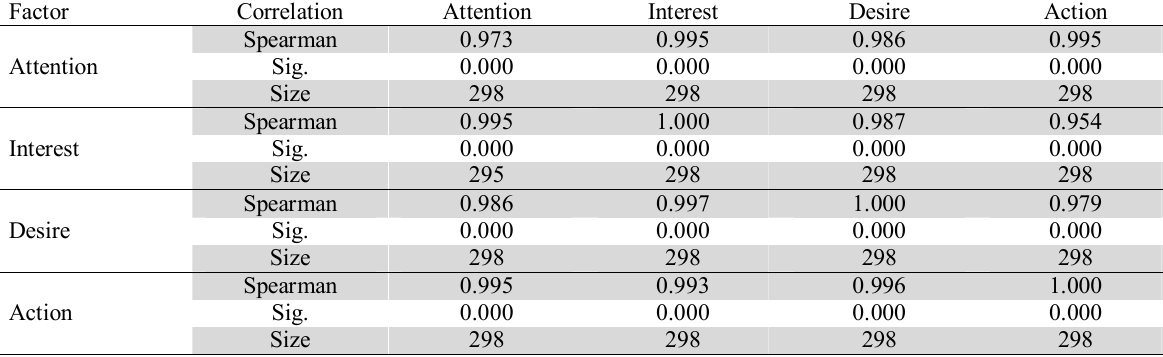
The summary of Spearman correlation